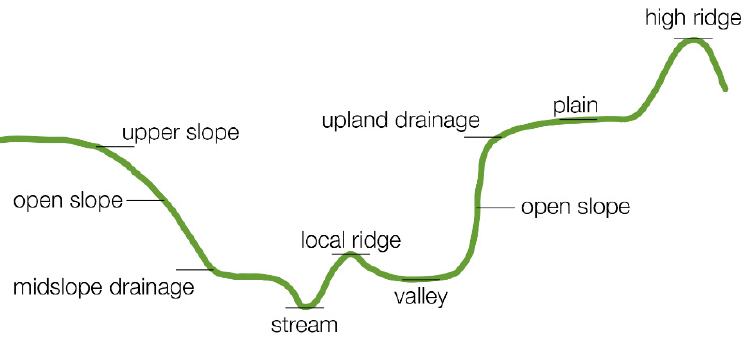
Figure 4. A schematic depiction of the morphological classes detected by the SAGA GIS module Topographic position index-based landform classification.